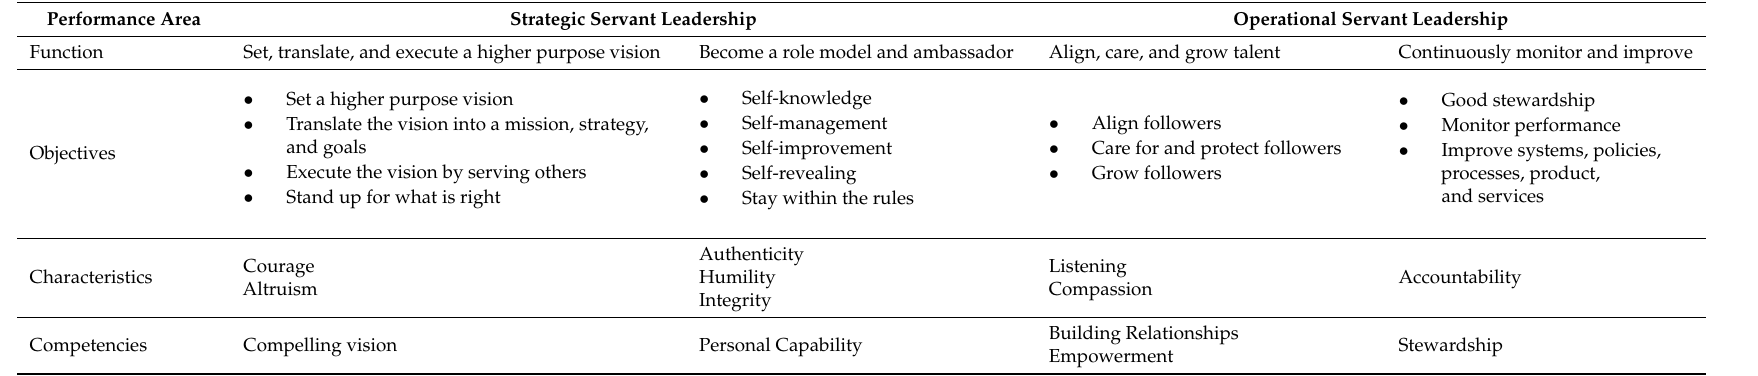
Table 4. Functions of a servant